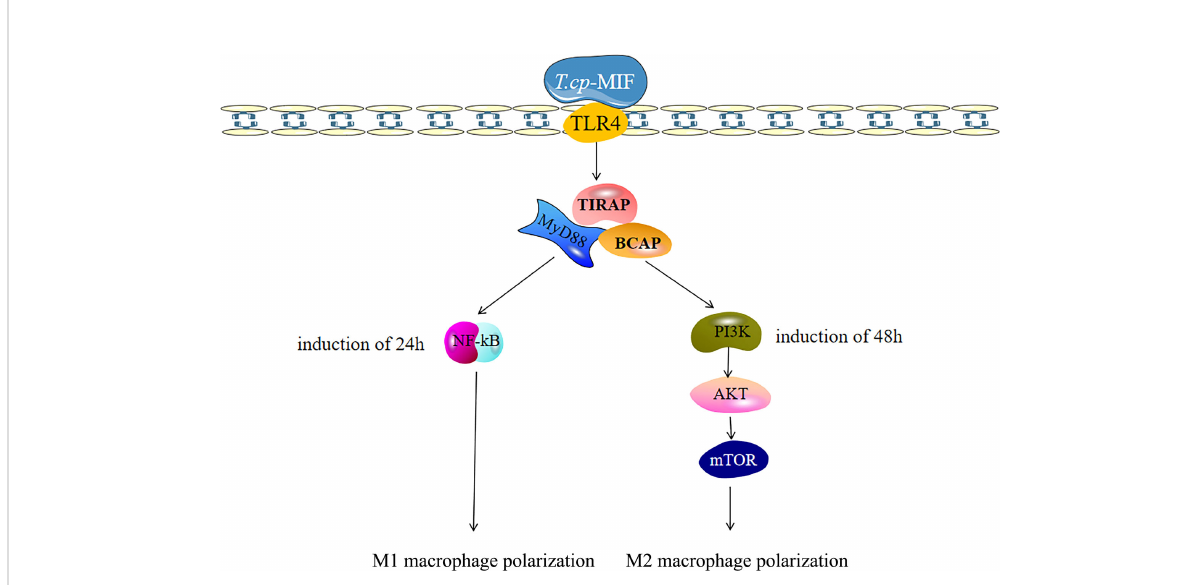
FIGURE 6 Polarization-related signaling pathway of macrophages was activated after T.cp -MIF treatment. The macrophages binded with TLR4, and T.cp - MIF activated NF- k B signaling pathway 24 hours after induction. At this time, macrophages showed M1 type polarization, while PI3K/AKT/mTOR signaling pathway is activated at 48 hours, making macrophages show M2 type